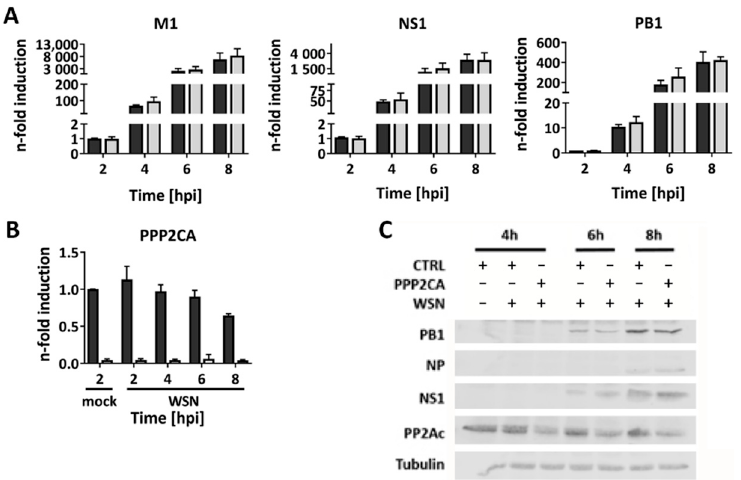
Figure 3. Viral transcription and translation is independent of high PP2Ac levels. ( A , B ) A549 cells were infected with WSN (MOI = 5), 48 h after siRNA-mediated KD of PP2Ac. Transcription of ex- emplary viral mRNAs as well as PP2Ac mRNA as KD control was analyzed using quantitative real- time PCR. Data are depicted as means + SD of three independent experiments with three biological replicates. Statistical significance was analyzed using a two-way ANOVA. ( C ) Expression of exem- plary viral proteins was analyzed using Western blotting. Blots are representatives of three inde- pendent experiments.